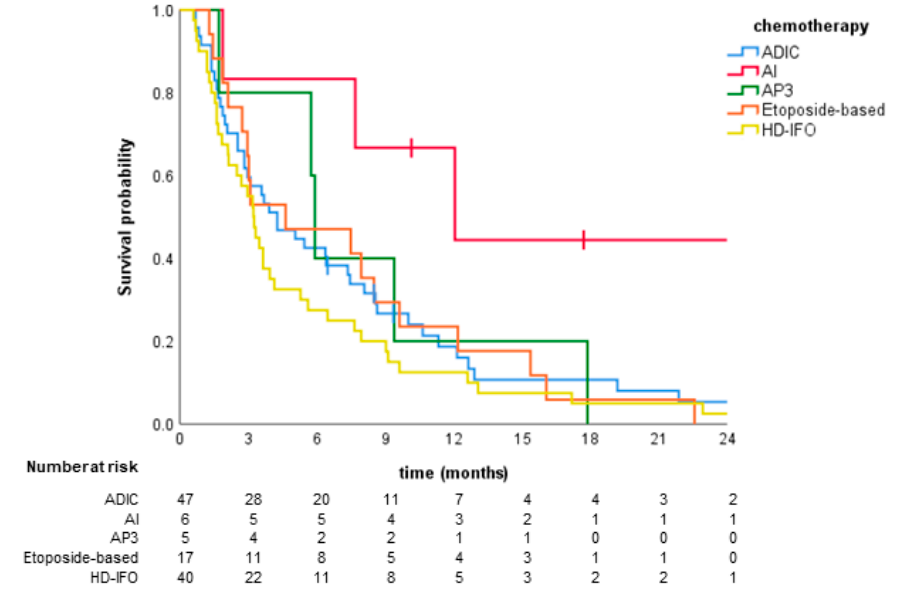
Figure 1. Progression-free survival stratified by chemotherapy regimens most commonly used in the first line. ADIC, doxorubicin + dacarbazine; AI, doxorubicin + ifosfamide; AP3, doxorubicin + cisplatin; EI, etoposide + ifosfamide; HD-IFO, high-dose ifosfamide. Table 2. Number of cycles of therapy, objective response rate (ORR) and median progression-free survival (PFS) in the first line of treatment depending on the used chemotherapy regimen.